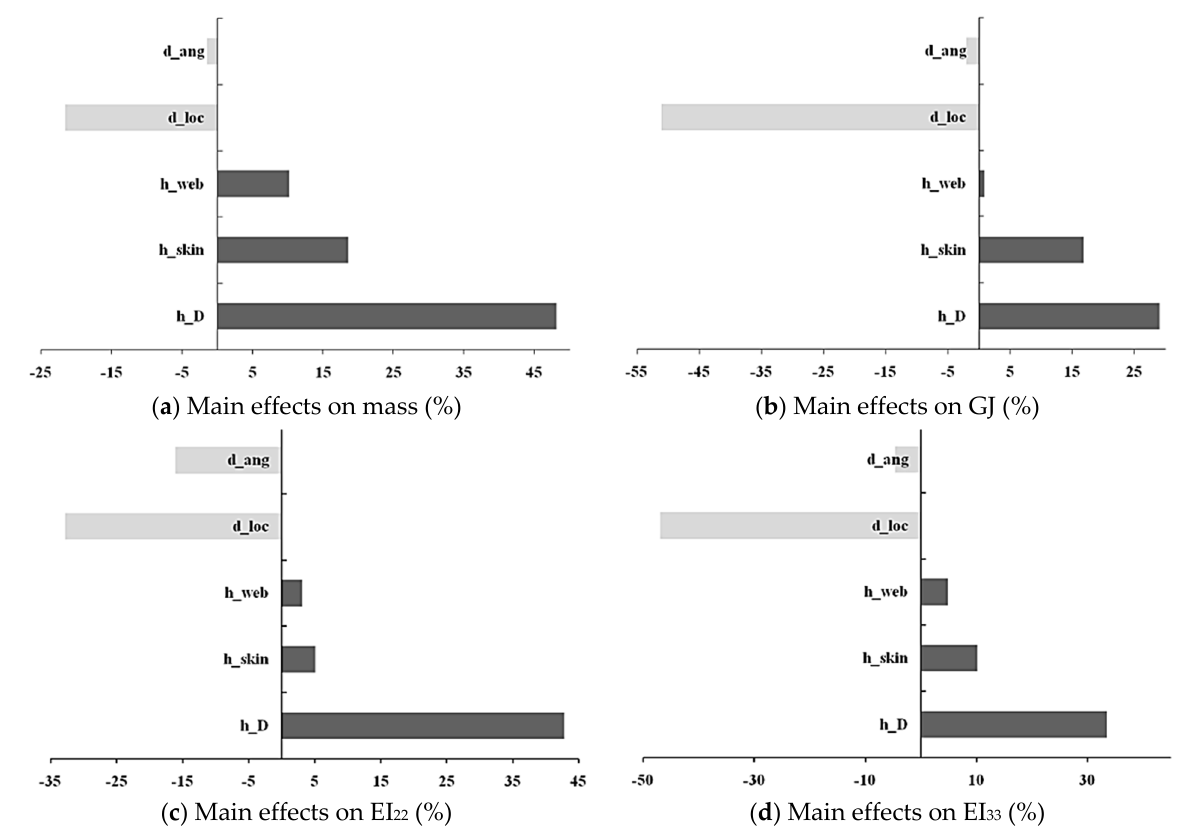
Figure 12. Main effects on design performance functions. Table 4. Results of accuracy according to variation of